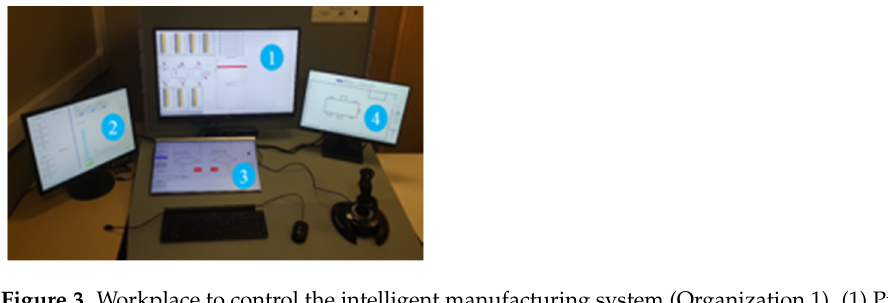
Figure 5. Logistics workplace (Organization 2). (1) Logistics control interface; (2) Tactical interface; (3) Bird’s eye view of the production cell. The mobile robots can either move autonomously or be teleoperated. A joystick was used to manipulate the direction in which the selected mobile robot moved when in the remote control level of automation. Under the autonomous level of automation, the mo- bile robot navigates autonomously toward an objective (geographical point) sent by the human operator by clicking on the map of the robot’s environment on the tactical inter- face, where the robot’s positions are displayed in real-time. The experimentation supervision workplace (cf. Figure 6) is added in the second experi- ment. It has been installed so that the experimenter can manage the experimentation through an interface that displays an overall view of the experimental environment. The experimentation supervision and production workplaces are connected, so that random failure can be triggered by the experimenter, who was also in charge of validating the loading and unloading of products. In addition, he/she could start, stop or pause the plat- form. As introduced in the previous section, an assistance system was provided to support humans in the control of the IMS. This assistance system can be used to simulate new potential field amplitudes and improve the self-organization of products. It also helps to manage overconsumption by reducing the amplitude of potential fields of high consump- tion production robots, as well as by postponing the manufacture of products requiring these production robots. This assistance system can be used when desired by the human operator.